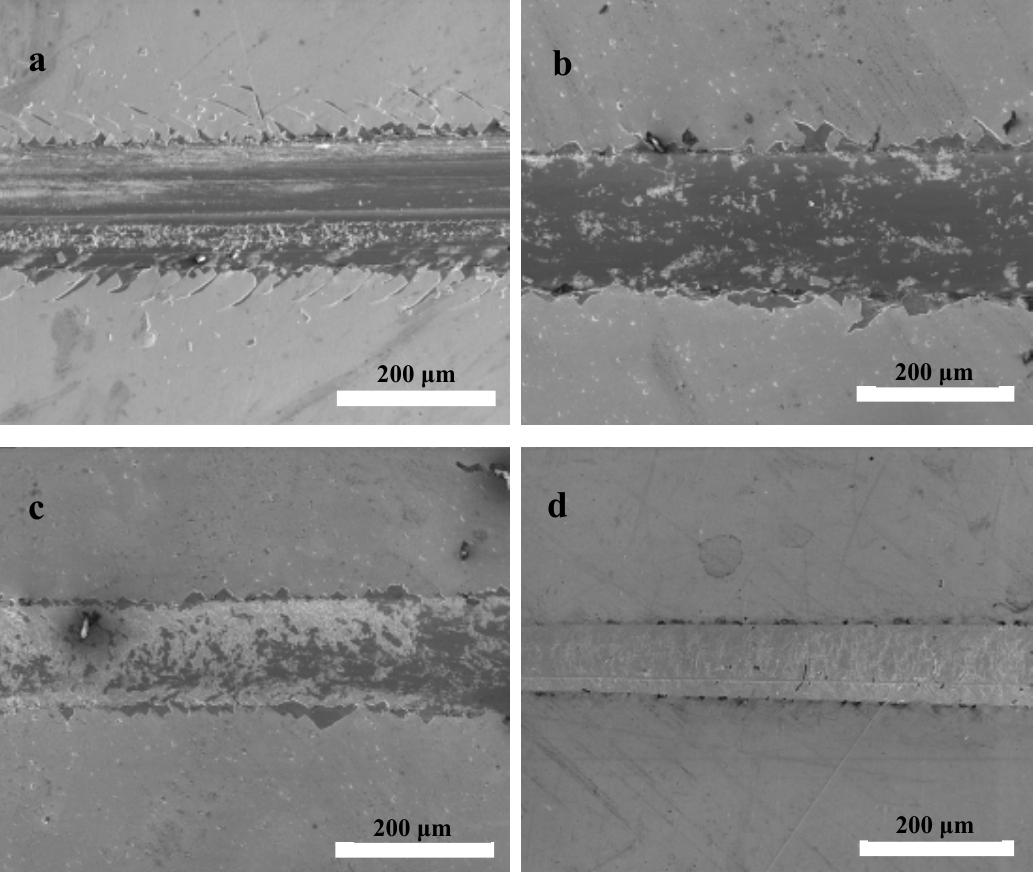
Figure 8. Typical scratch track images of HfC coatings deposited at different bias voltages: ( a ) 0 V, ( b ) − 100 V, ( c ) − 150 V, and ( d ) − 200 V.